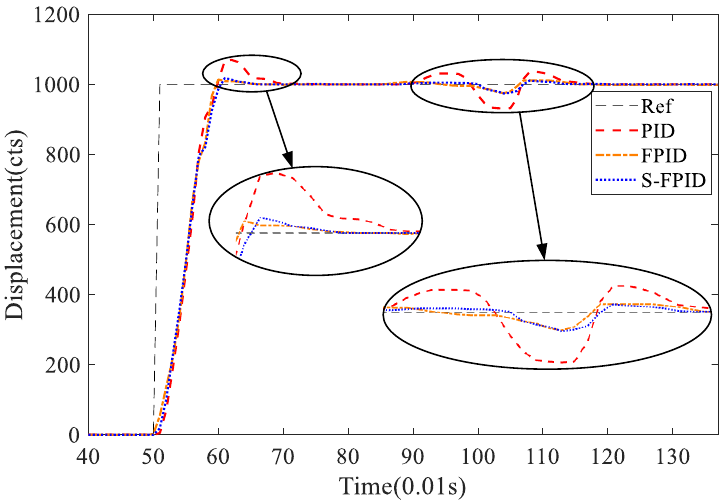
Figure 16. Experimental results of step response with